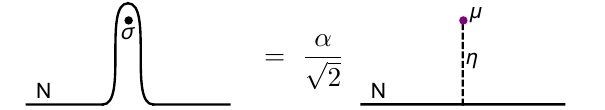
Figure 29 . In the critical Ising model, moving the TDL N past the spin (cid:12)eld (cid:27) leaves behind the Z 2 line (cid:17) attached to the defect operator (cid:22) 2 H (cid:17) , and a T-junction. N is the order/disorder duality defect that exchanges (cid:27) with (cid:22) .